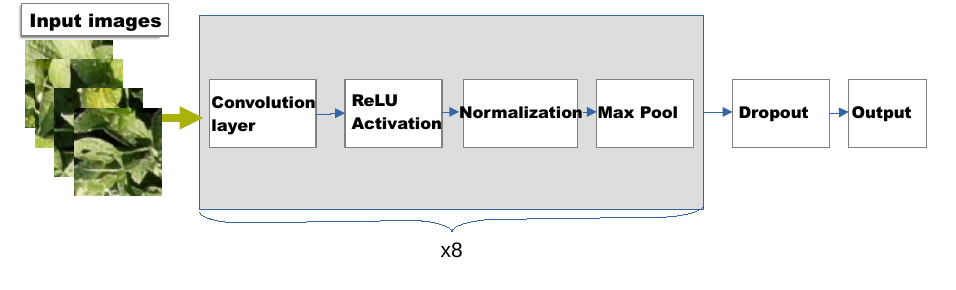
Figure 3. Architecture of DefoNet [5].